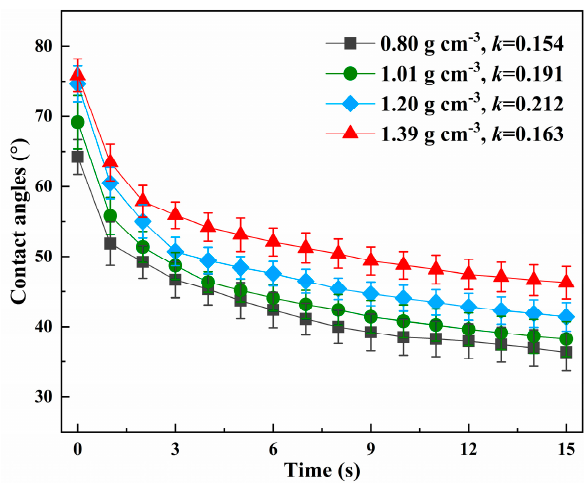
Figure 1. Contact angles of water as a function of time for scrimbers with various densities.